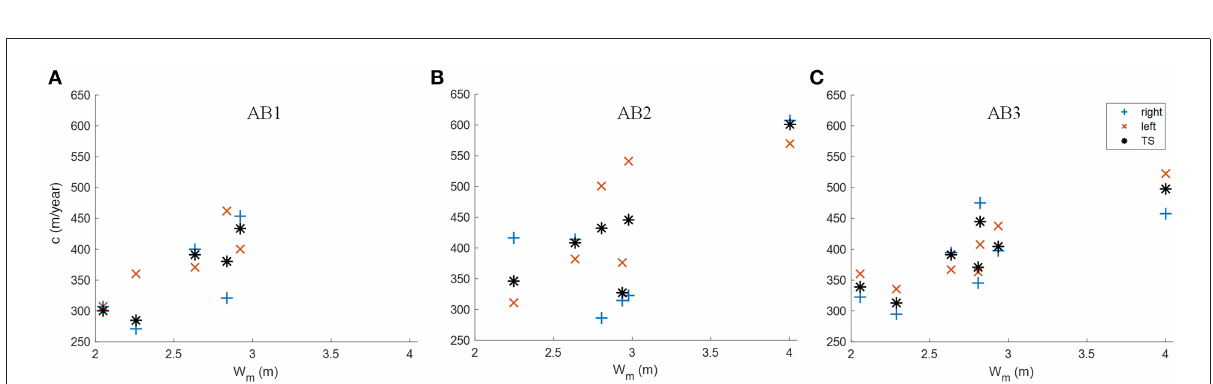
FIGURE11 Bar celerity in the investigated sections [ (A) : AB1, (B) : AB2, and (C) : AB3] plotted over the average water stage measured in the period between subsequent echo sounder survays at the gauging station Neu Darchau (Ekm 536).